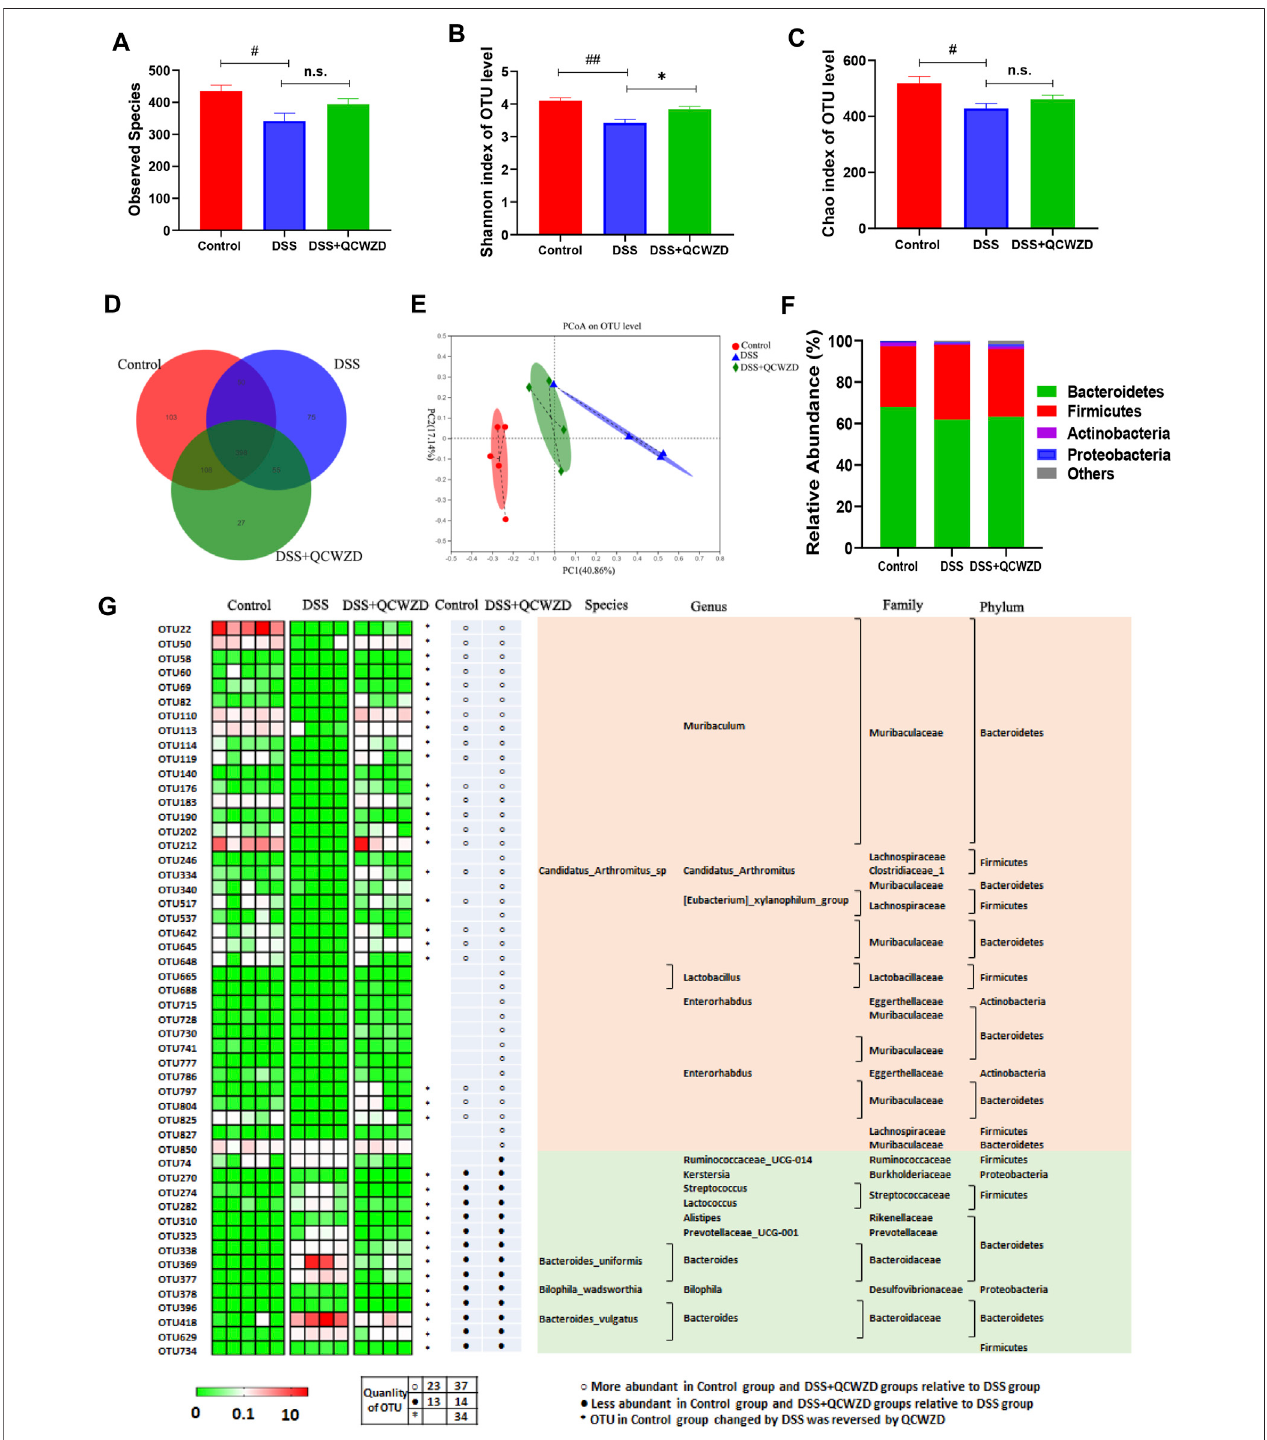
FIGURE 3 | Supplementation of QCWZD Modulates Composition and Functionality of gut microbiota in DSS-Induced Colitis Mice. After a week of QCWZD intervention or sterile water, fresh feces from each mouse were collected for bacterial 16S rRNA sequencing analysis ( n (cid:2) 4 – 6 mice/group). (A, B) Comparison of the observed bacterial species and Shannon index of different groups. (C) Venn diagram of OTUs. (D) Principal Coordinate Analysis (PCoA) based on Bray-Curtis distance amongdifferentsamples. (E,F) Bacterialtaxonomicpro fi linginthephylumandgenuslevelofintestinalbacteriafromdifferentmousegroups. (G) Heatmapshowing the abundance of51OTUssigni fi cantlyaltered byQCWZDin DSS-treated mice.The colorofthespots intheleft panel represents the relative abundance oftheOTUs in each group. In the middle panel, white and black circles indicate the OTUs increased or decreased in the Control and DSS + QCWZD groups relative to the DSS group, respectively;blackstarsrepresentOTUswhoseabundanceintheControlmicewasalteredbyDSStreatmentandthenreversedbyQCWZD.Thespecies,genus,family and phylum names of the OTUs are shown on the right panel. The analyses were conducted using R software version 3.3.1.